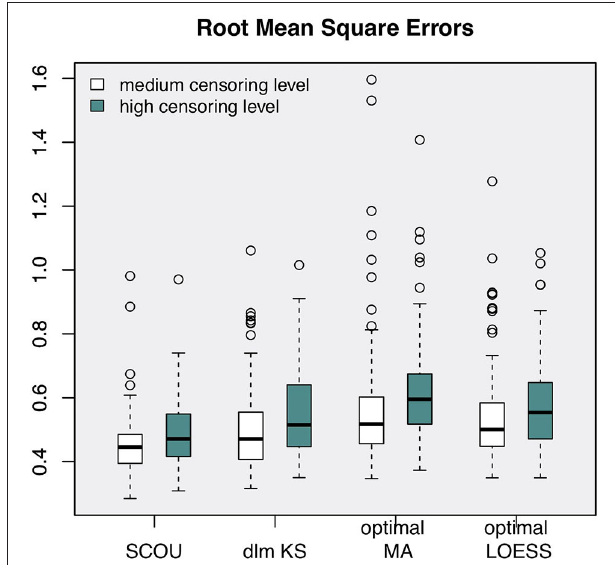
FIGURE 5 | Root Mean Squared Errors for the prediction of X for 4 competitive smoothing methods [the proposed smoother (SCOU), the 2-parameter Kalman Smoother, the LOESS, and the moving average (MA)], with 16 % and 31 % of censored data (respectively white and cyan boxes).